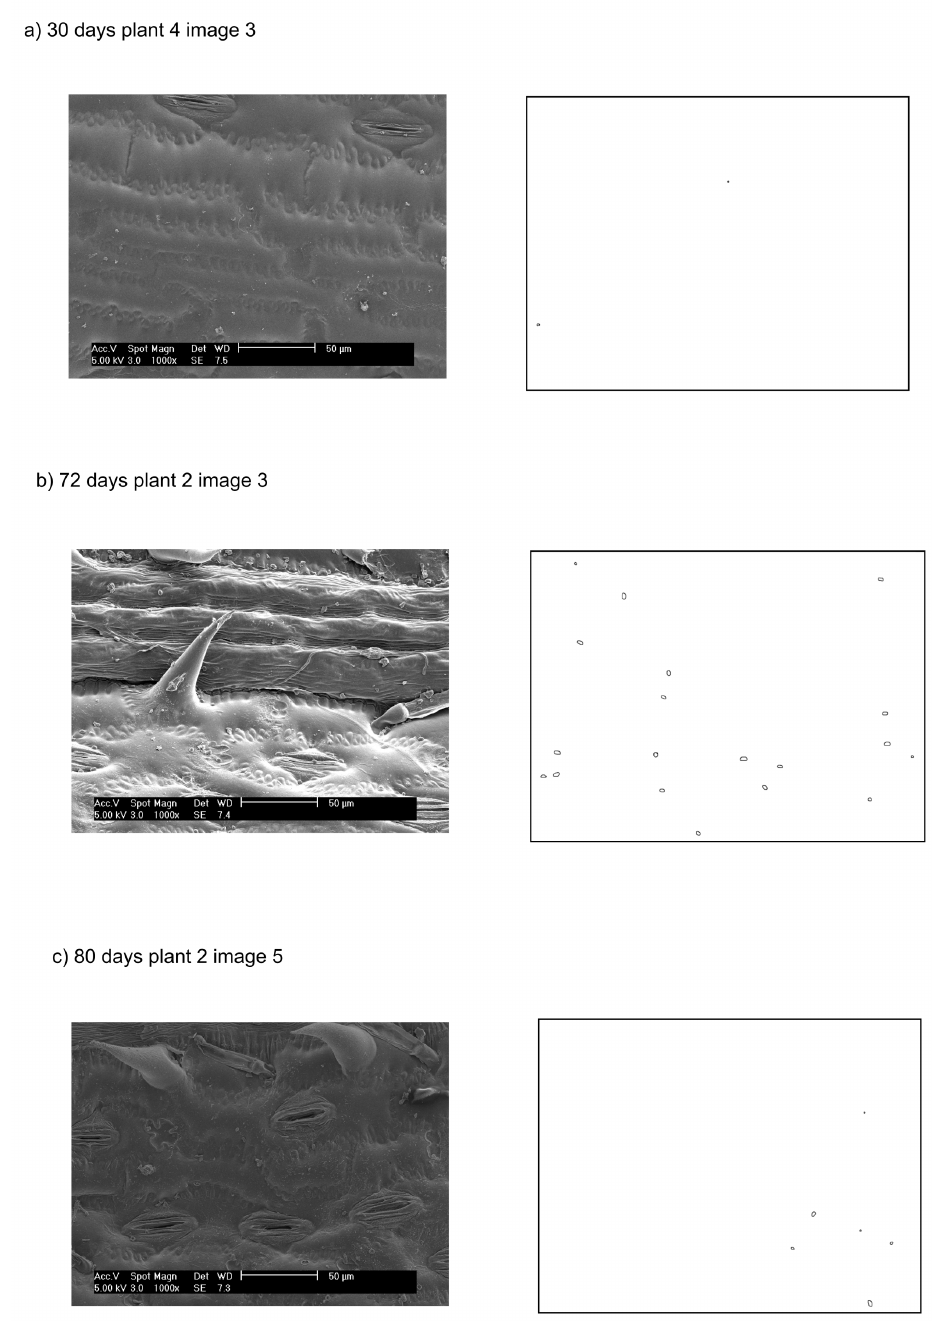
Figure 2. Example SEM (left panel) and bacterial overlay images (right panel). A ) Typical image after 30 days of growth in the field. B ) 72-day image, with leaf hair and stomata clearly visible. C ) Typical image after 80 days of growth in the